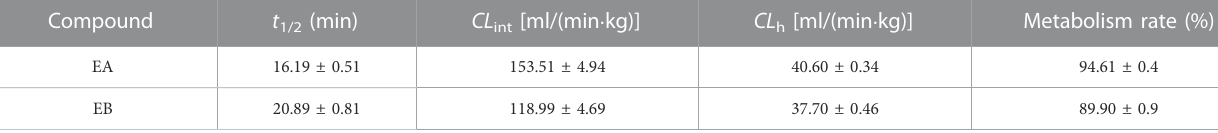
TABLE 3 Hydrolytic clearance parameters of EA and EB incubated with RLMs (mean ± SD; n = 3). Compound